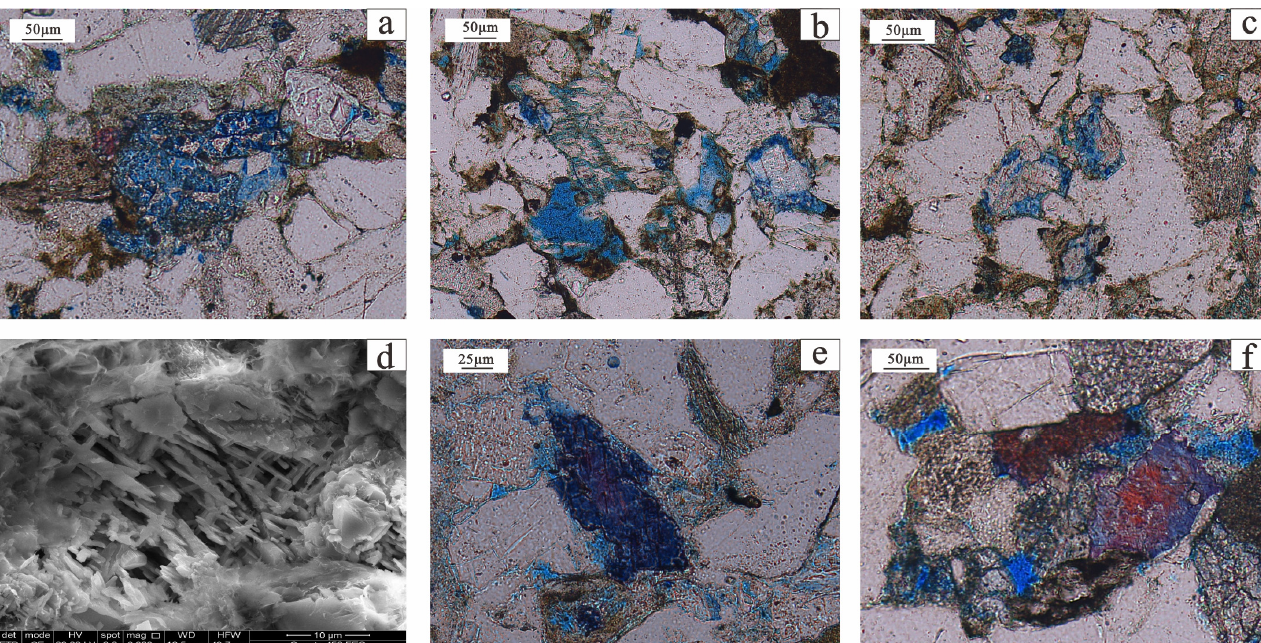
Figure 8. Dissolution of the Chang-7 Member in the Ordos Basin. ( a ) L190, 2267.8 m, hollowed-out particle residues formed by partial dissolution of feldspar; ( b ) Z255, 1748.4 m, melodic pores; ( c ) X62, 1838.82 m, harbor-like dissolution pores; ( d ) L338, 2329.3 m, grid corrosion pores; ( e ) Z255, 1774.5 m, ankerite boundary is corroded; ( f ) M27, 2745 m, calcite particle boundary is corroded.